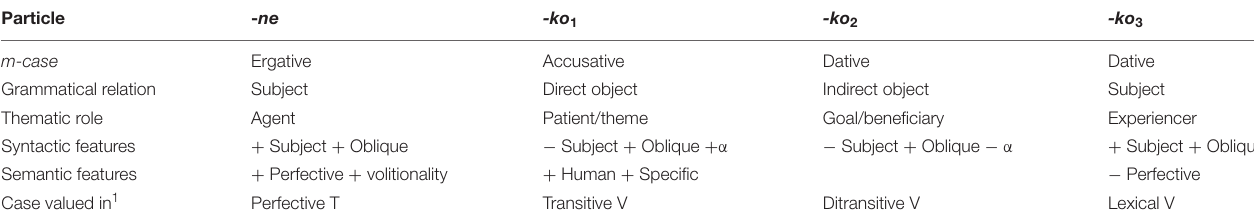
TABLE 2 | Summary of the Hindi case particles examined in this